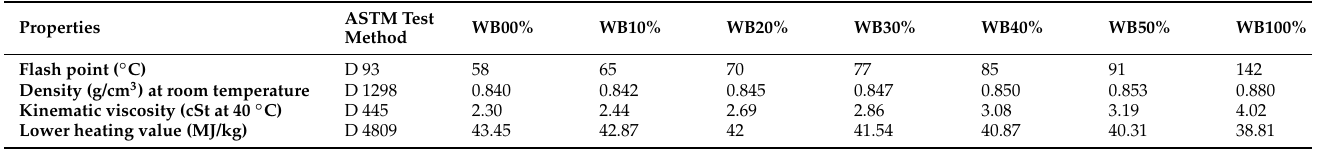
Table 2. Physicochemical properties of petrol–diesel and blended biodiesel.